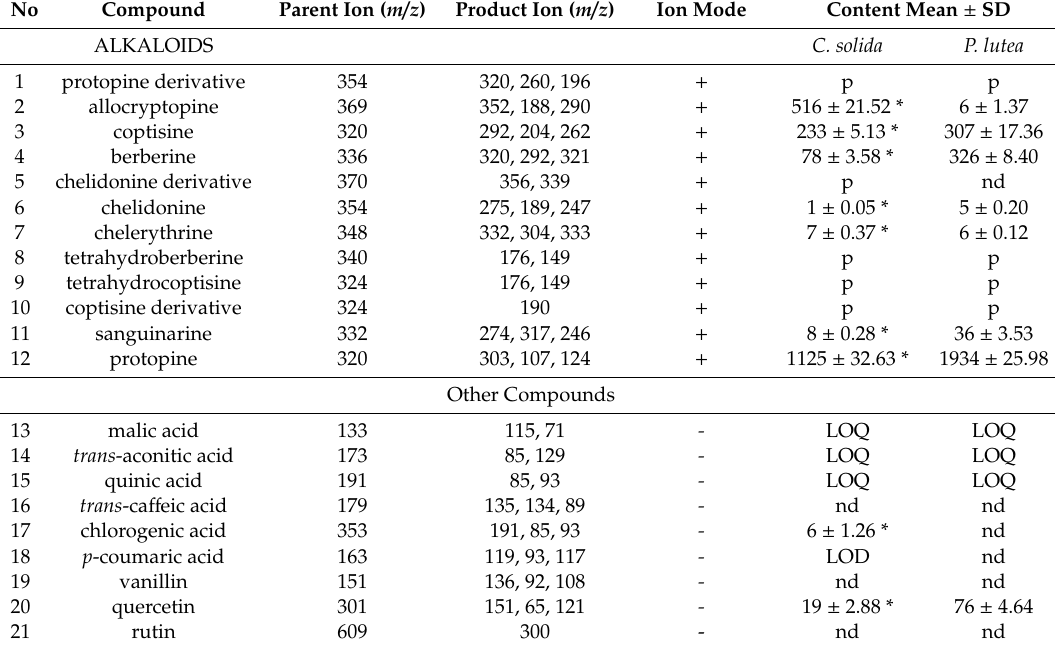
Table 2. The content ( µ g / g d.w. ± SD) of quantitated compounds in underground parts of C. solida and P. lutea